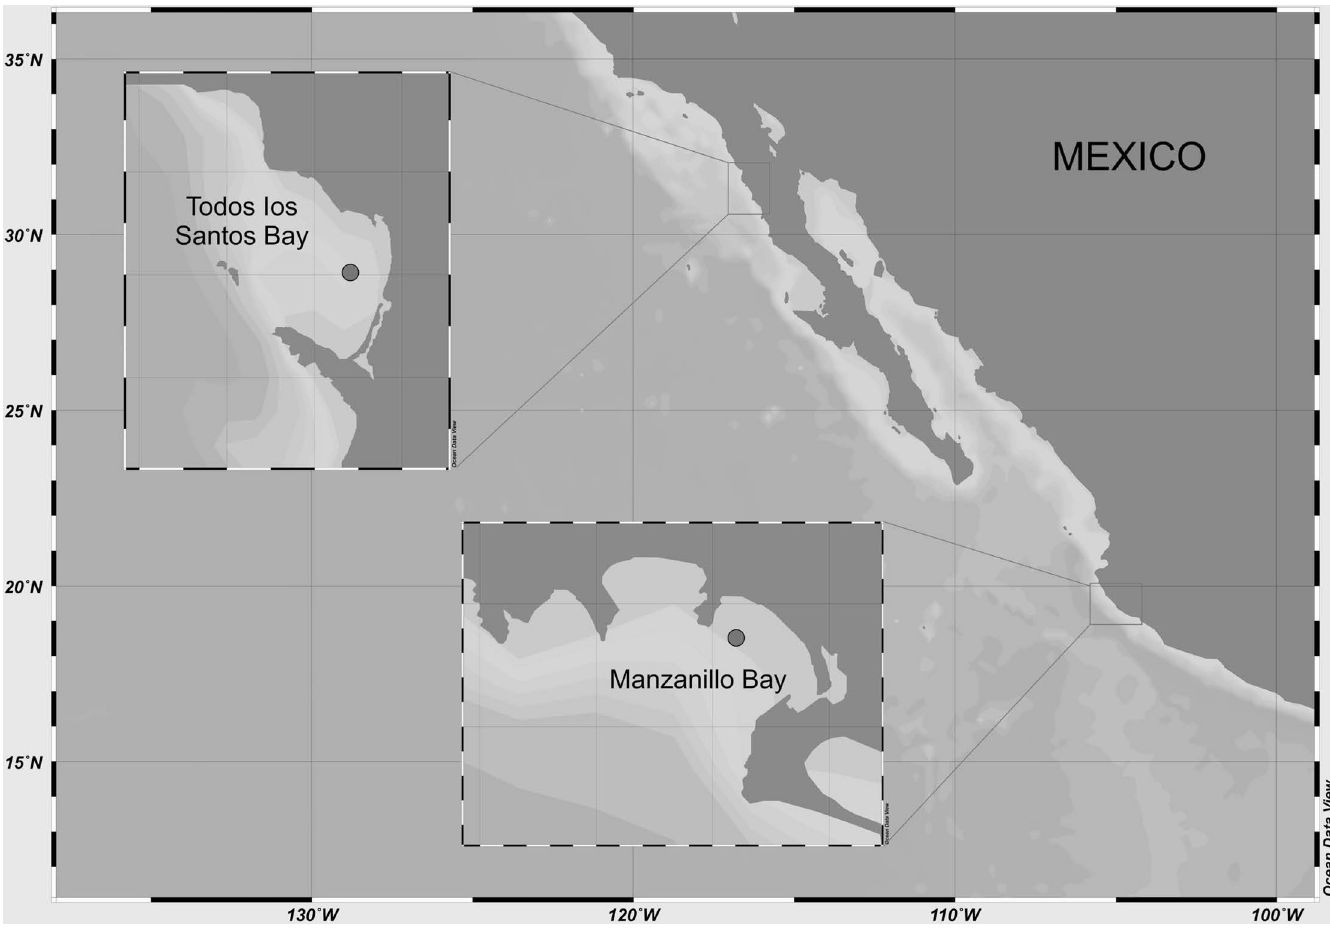
Fig 4. Map of the Mexican Pacific coast showing Todos Santos and Manzanillo